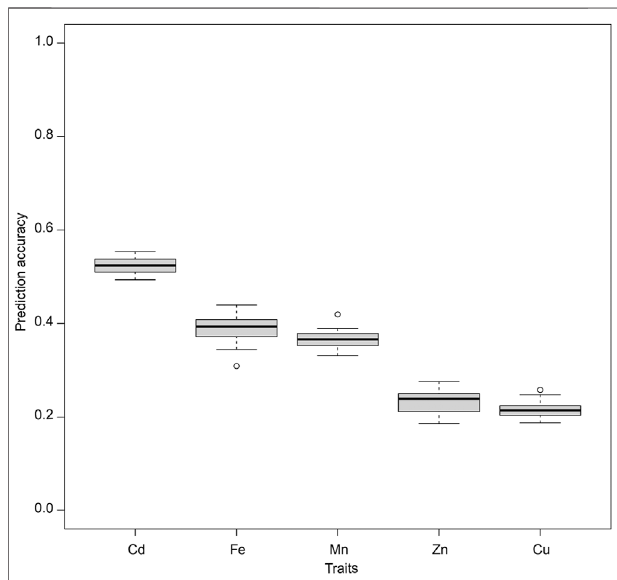
FIGURE 2 | Genomic prediction accuracies of the studied traits were assessed using a single trait GBLUP (ST-GBLUP) model.